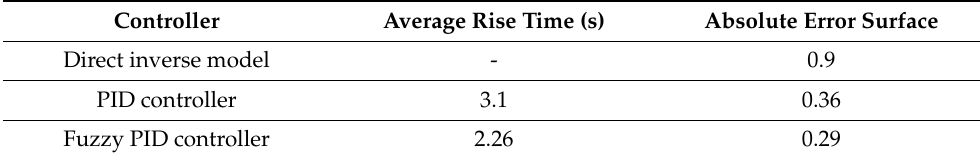
Table 5. Performance of the controllers on the test bench with fuel